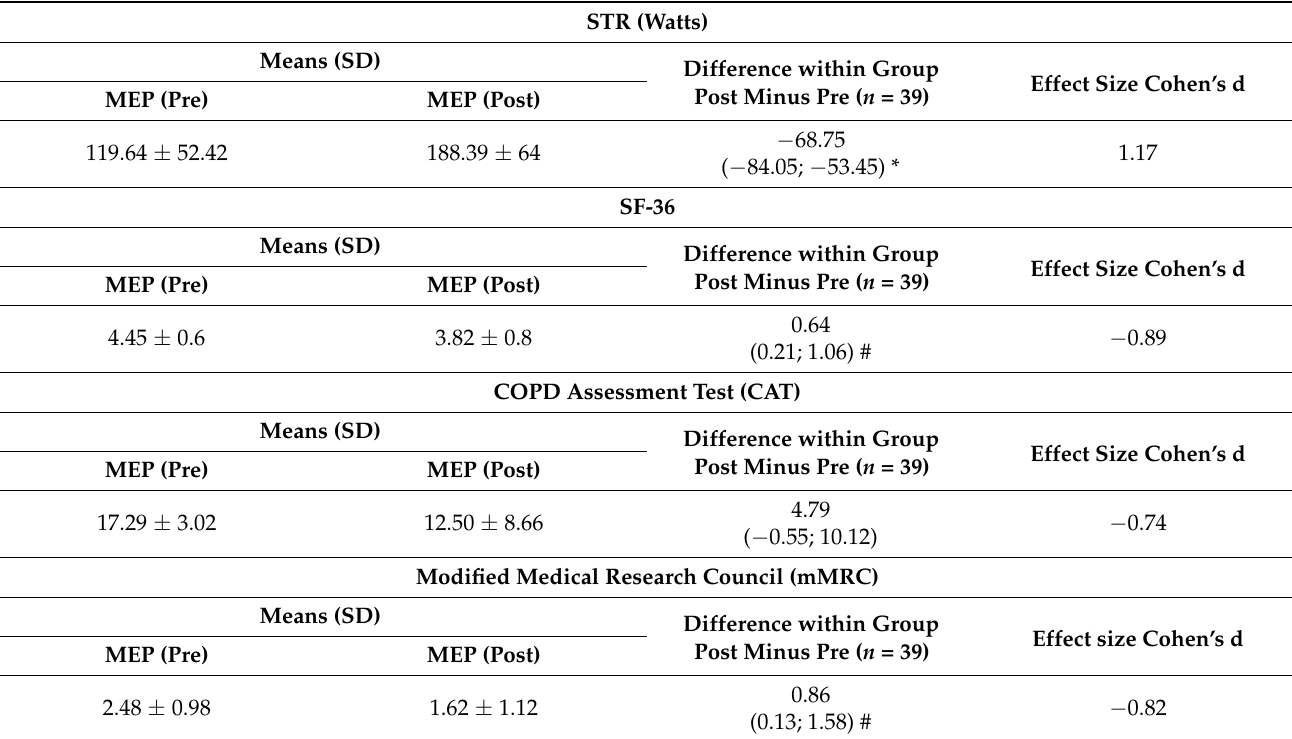
Table 2. Adjusted means (SD) for outcome at all study visits and mean (SD) difference within group and effect